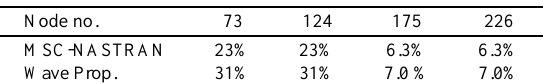
Table 1 SRS residual levels at high frequency for the various control